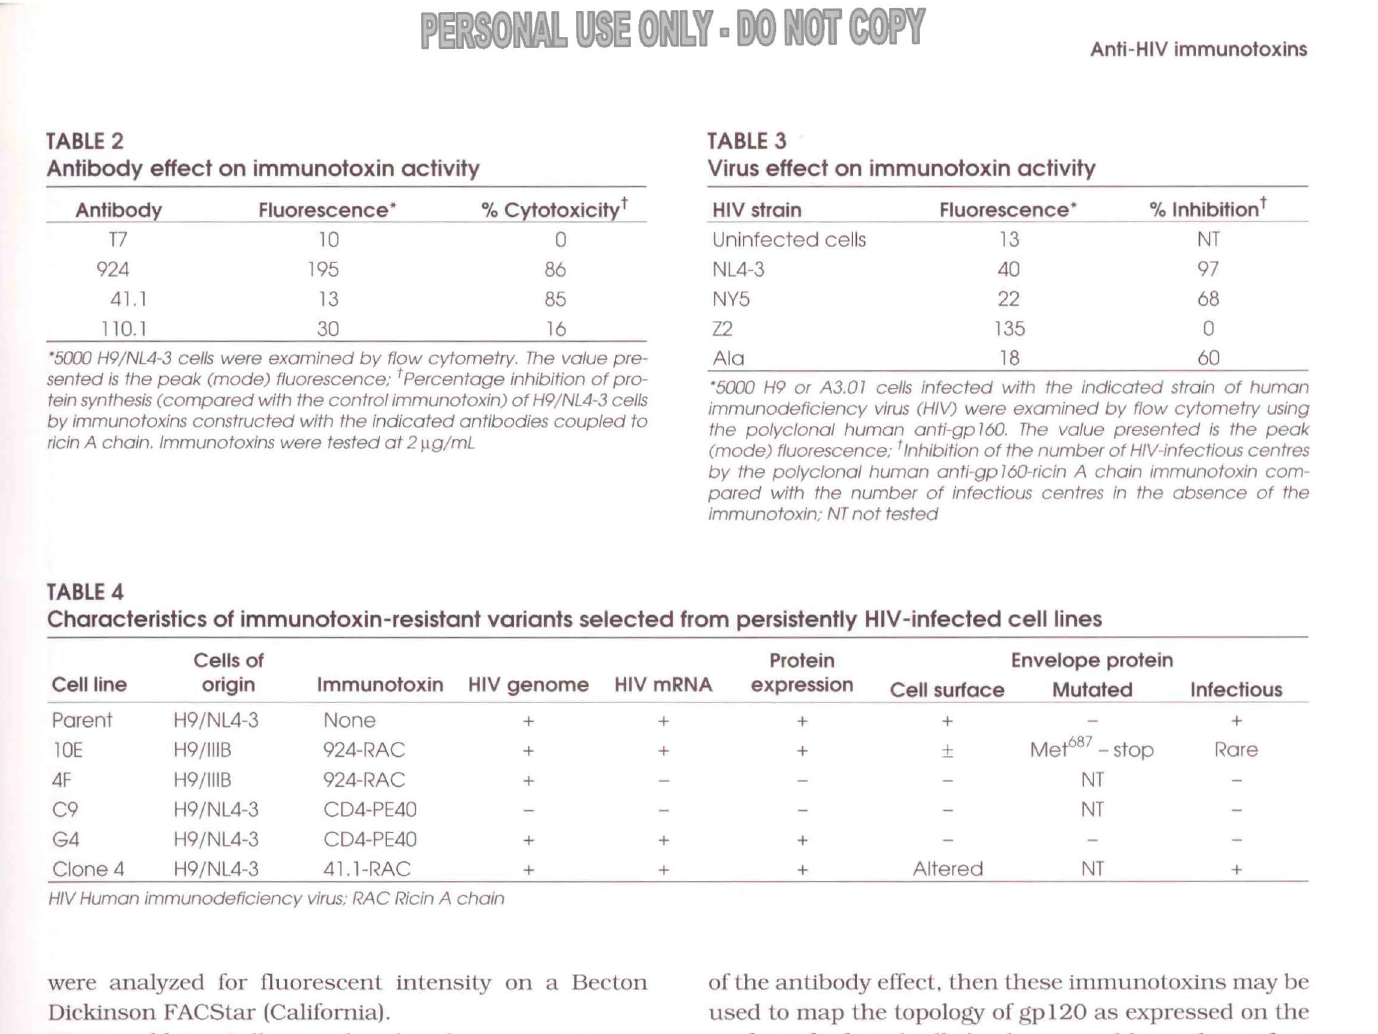
Antibody effect on immunotoxin